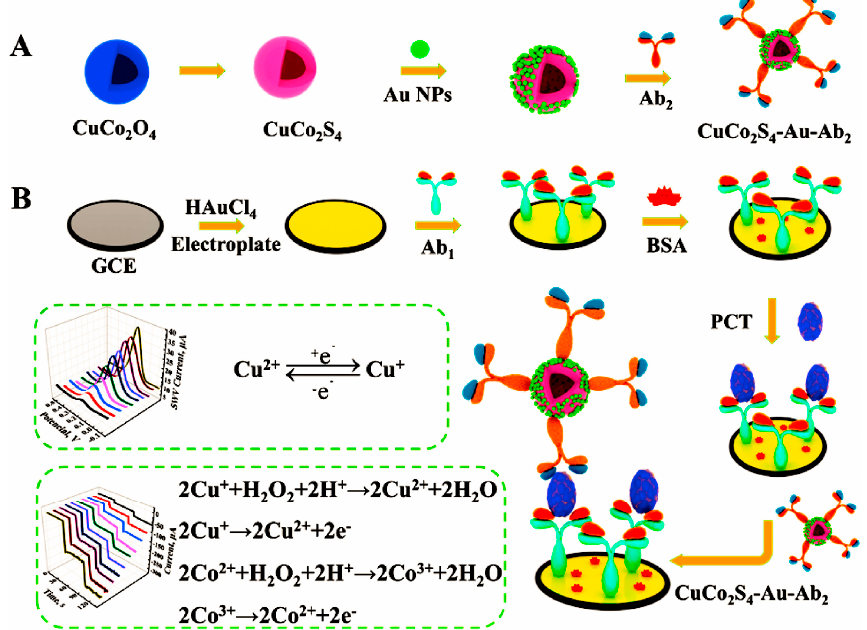
Figure 10. Schematic diagram of the preparation of the nanometal immunosensor complex CuCo 2 S 4 –Au–Ab 2 ( A ) and the construction of the immunosensor ( B ) [94]. Copyright (2020) Elsevier. Medetalibeyoglu et al. used the MXene@AuNP signal-amplifying probe, AuNPs, and